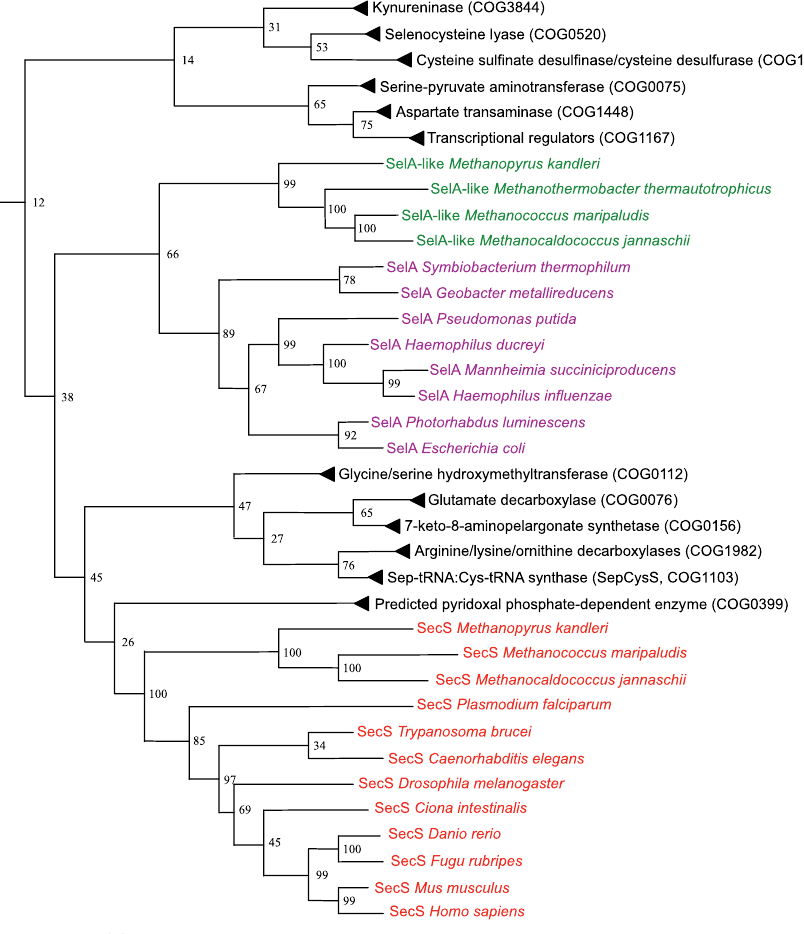
Figure 1. Phylogenetic Tree of SecS, SelA, SelA-Like, and Other PLP-Dependent Proteins SecS proteins are shown in red; SelA in pink, and archaeal SelA-like proteins in green. Other PLP-dependent protein branches are compressed and represented by family names. The phylogenetic tree was generated by ClustalW and PHYLIP programs. Both bootstrap support (the number of times each branch was supported in bootstrap replication) and the measurement of distance for the branch lengths (shown by a bar) are indicated.